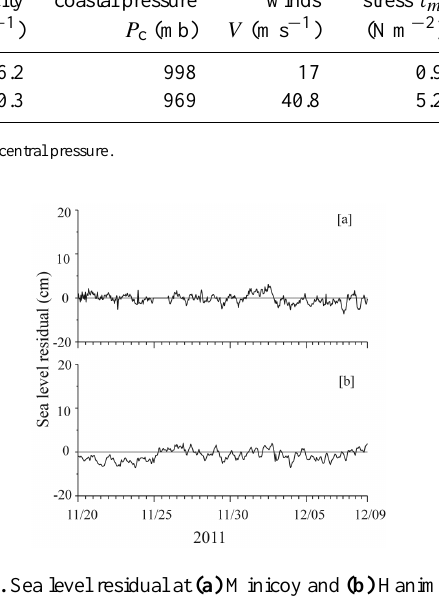
Figure 13. Sea level residual at (a) Minicoy and (b) Hanimaadhoo. Note: 1 – Sea level data at Minicoy (b) Hanimaadhoo is at hourly interval and downloaded from